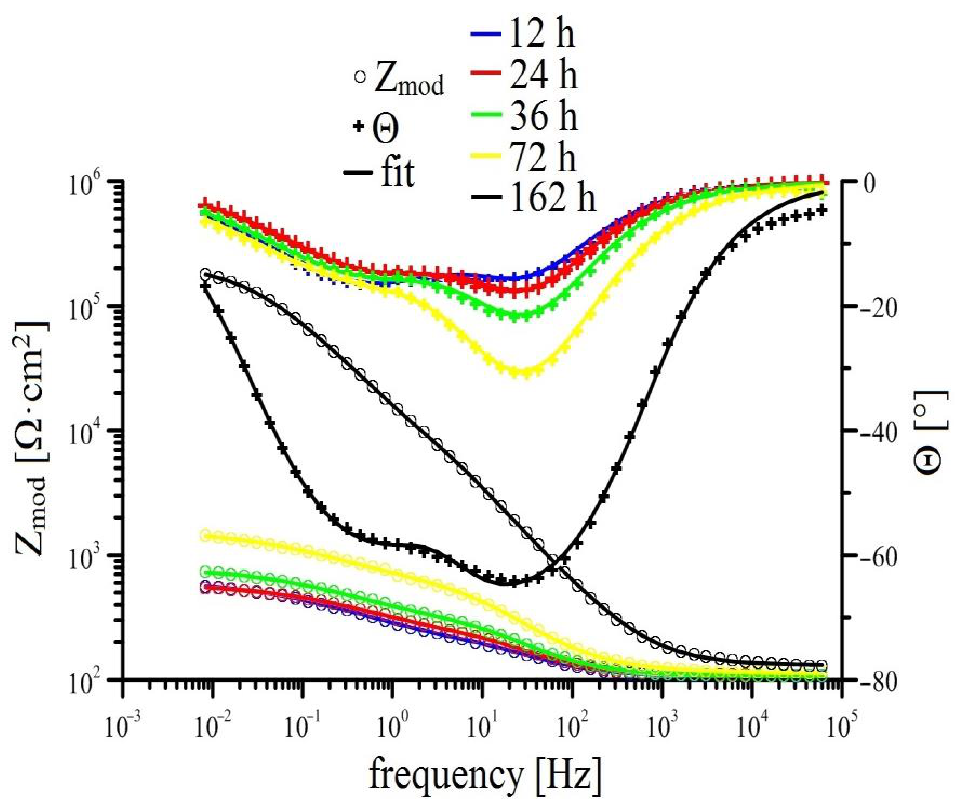
Figure 9. Time-dependent impedance spectra for Mn (1) solution (Bode plot: log Z mod vs. log frequency and phase angle vs. log frequency).